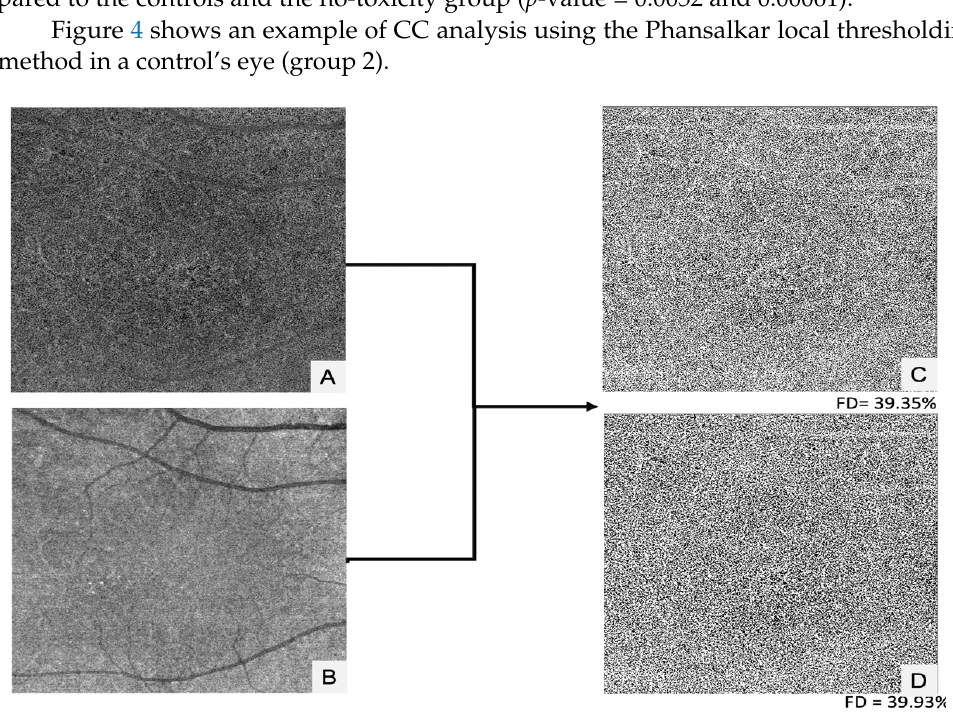
Figure 4. Choriocapillaris analysis using the Phansalkar local thresholding method in a healthy